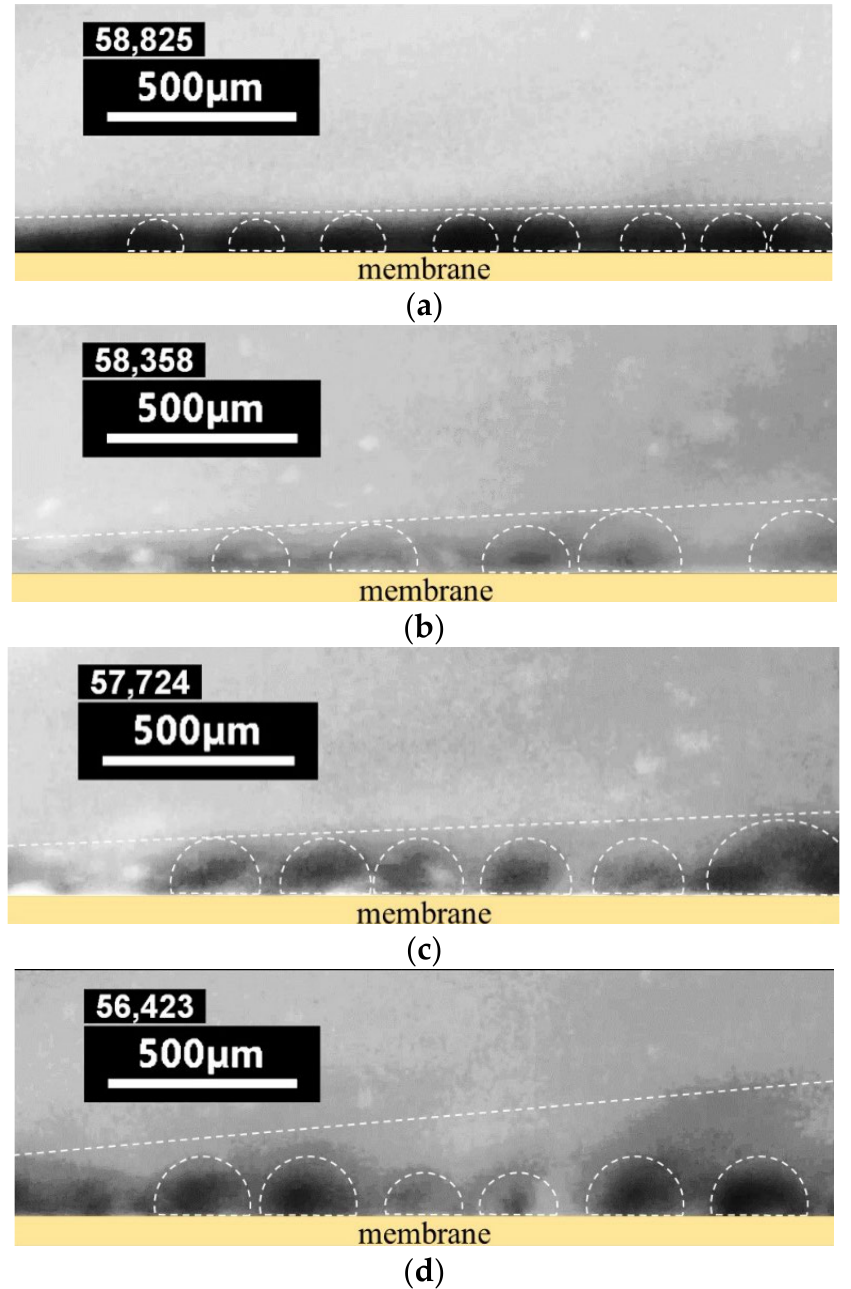
Figure 8. Visualization EC vortexes near the MA-41P ( a ), MA-41Pmod ( b ), Ralex AMH-PES ( c ), and Ralex AMH-PESmod ( d ) membranes during electrodialysis. Supplementary Videos S1–S4 match the same membranes in the same order. Dark areas correspond to a low concentration of rhodamine. The vortexes are circled for clarity.